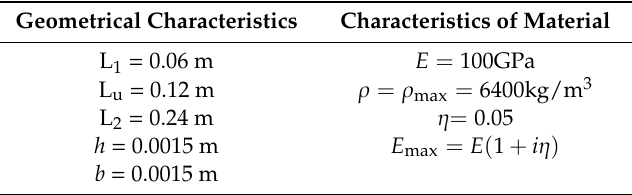
Table 1. Geometrical and material characteristics of the beam.